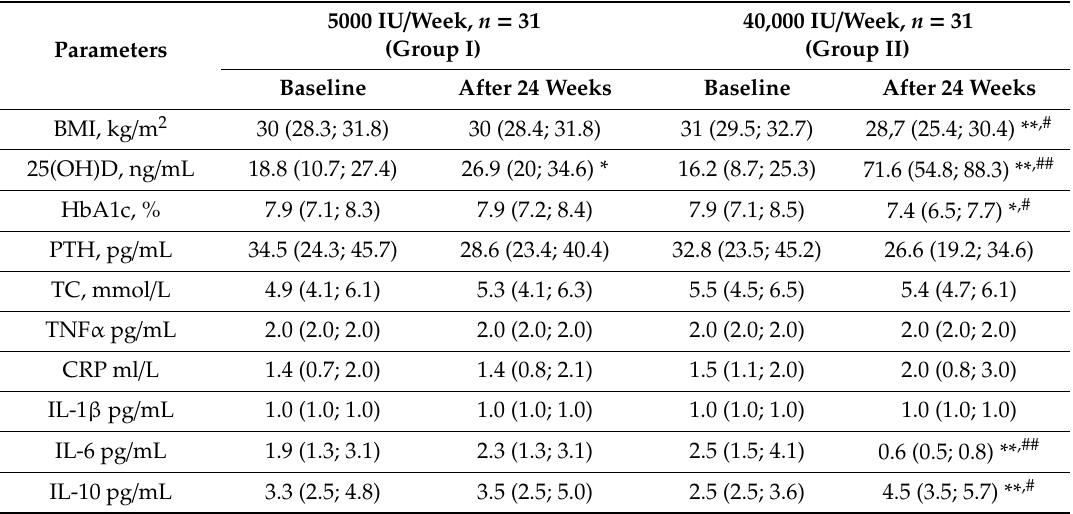
Table 2. Anthropometric and laboratory parameters at baseline and after 24-week